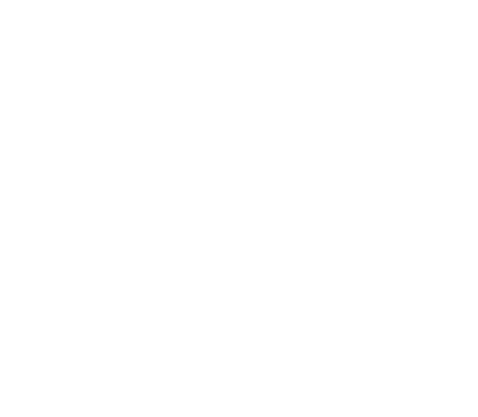
Figure 7. One phase voltage comparison of the one-module motor and two-module motor by FEAM and test.